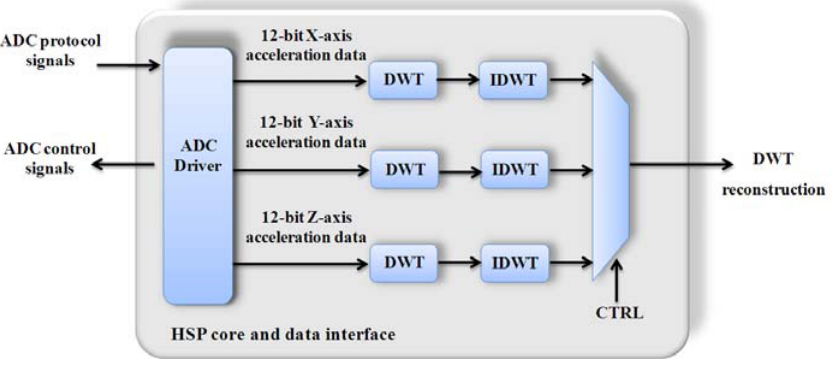
Figure 5. Block diagram for vibration monitoring utilizing the HSP